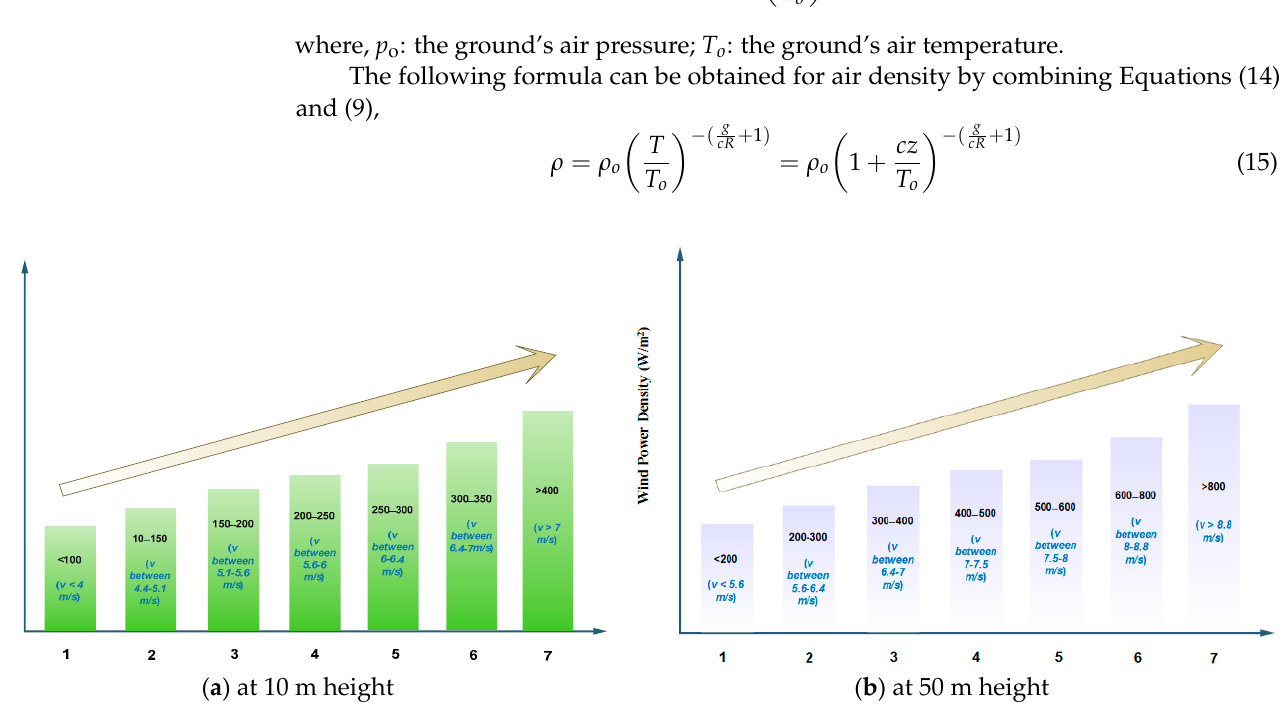
Figure 1. The categories of wind power density. Adapted with permission from Ref. [11]. 2010 WIT